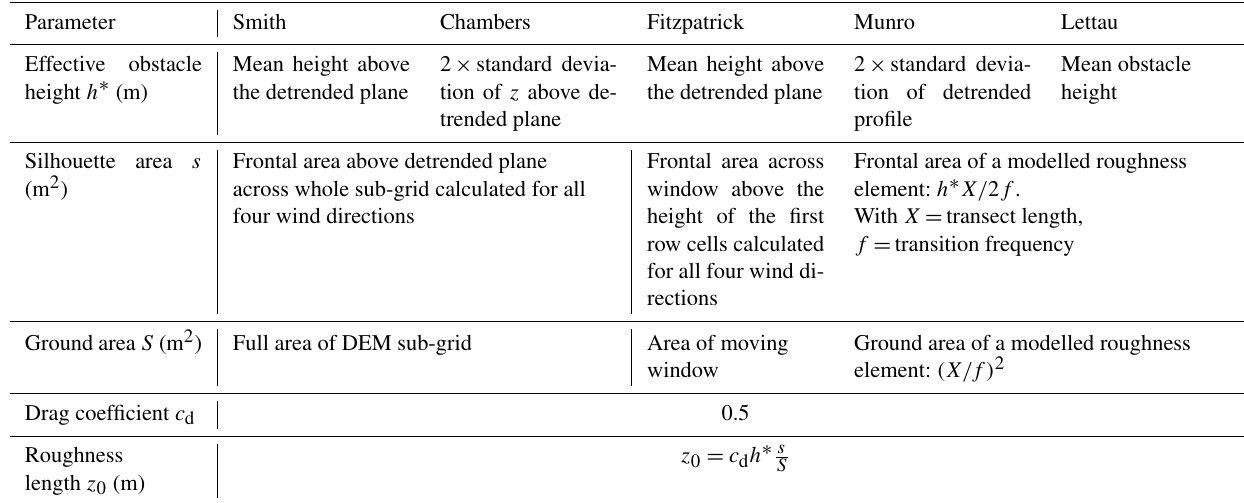
Table 3. Overview of parameters from Eq. (1) of Lettau (1969) used for the z 0 calculation of each model. Parameter Smith Chambers Fitzpatrick Munro Lettau Mean obstacle Mean height above 2 × standard devia- Effective obstacle height the detrended plane tion of detrended profile trended plane Frontal area of a modelled roughness Frontal area above detrended plane Frontal area across element: h ∗ X/ 2 f . across whole sub-grid calculated for all window above the With X = transect length, four wind directions height of the first f = transition frequency row cells calculated for all four wind di- rections Ground area S (m 2 ) Full area of DEM sub-grid Area of moving Ground area of a modelled roughness window element: (X/f ) 2 Drag coefficient c d 0.5